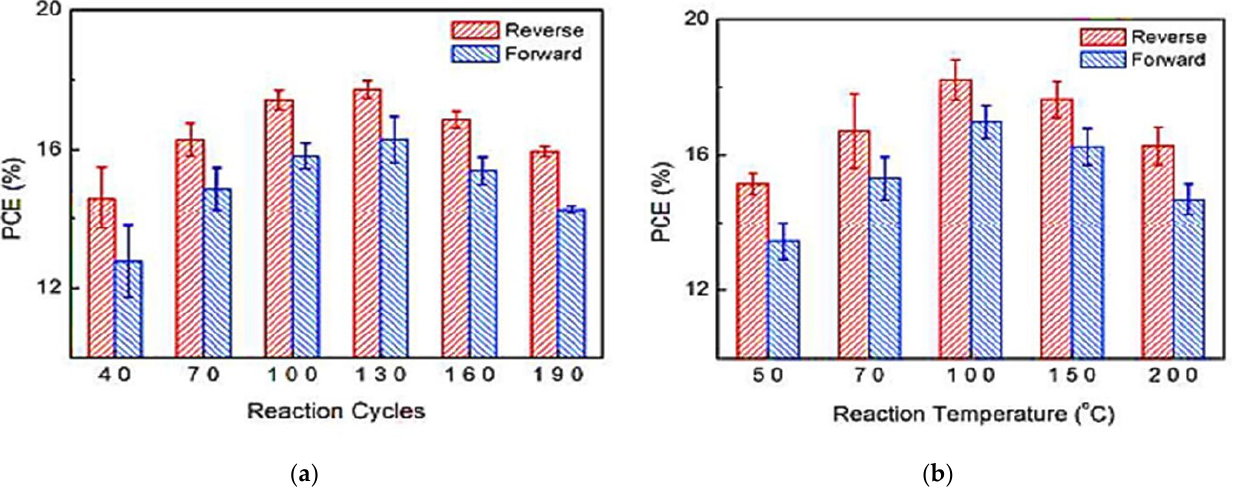
Figure 7. Power conversion efficiency (PCE) as a function of ( a ) reaction cycles; ( b ) process temperature. Reprinted with permission from Ref. [75]. Copyright 2016, Royal Society of Chemistry.